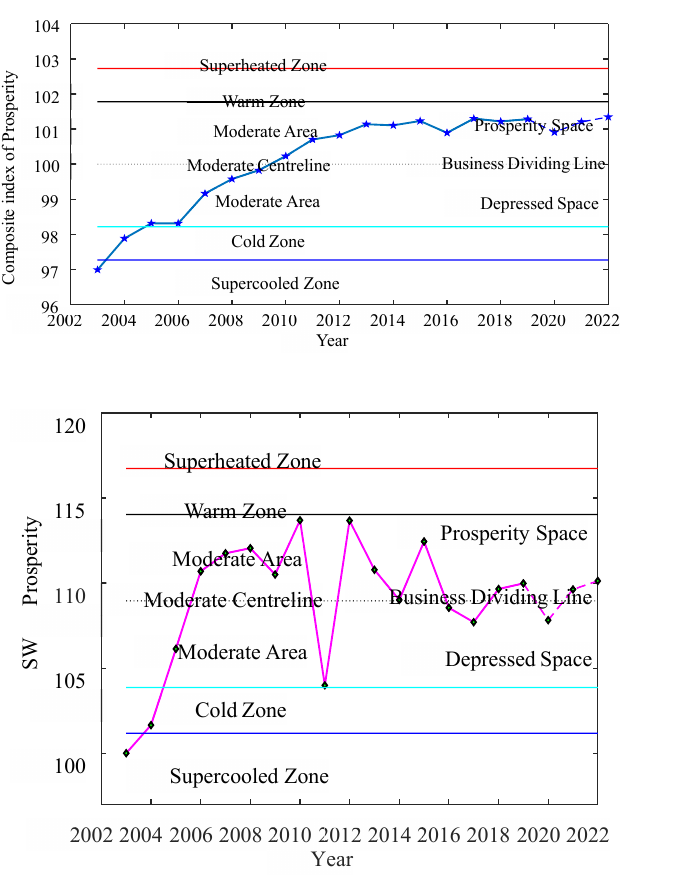
Figure 12. 2020 – 2022 China ’ s marine economic operation SW prosperity index indirectforecastresults